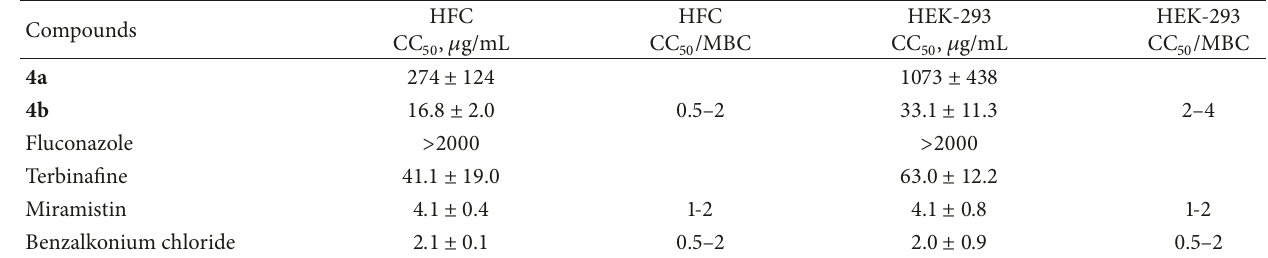
Table 5: Cytotoxicity of 4a,b and the reference drugs (mean ± SD).